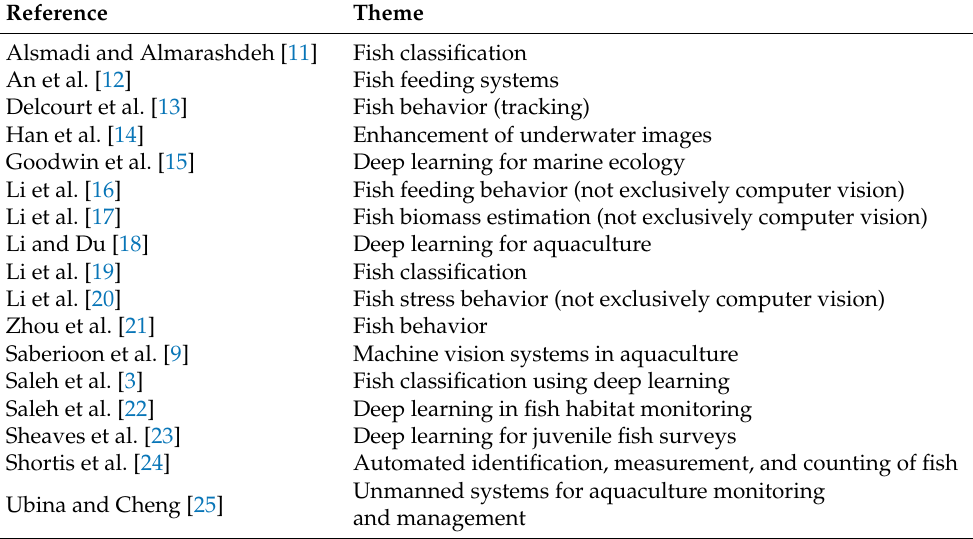
Table 1. Review and survey articles dealing with computer vision applied to fish recognition, monitoring, and